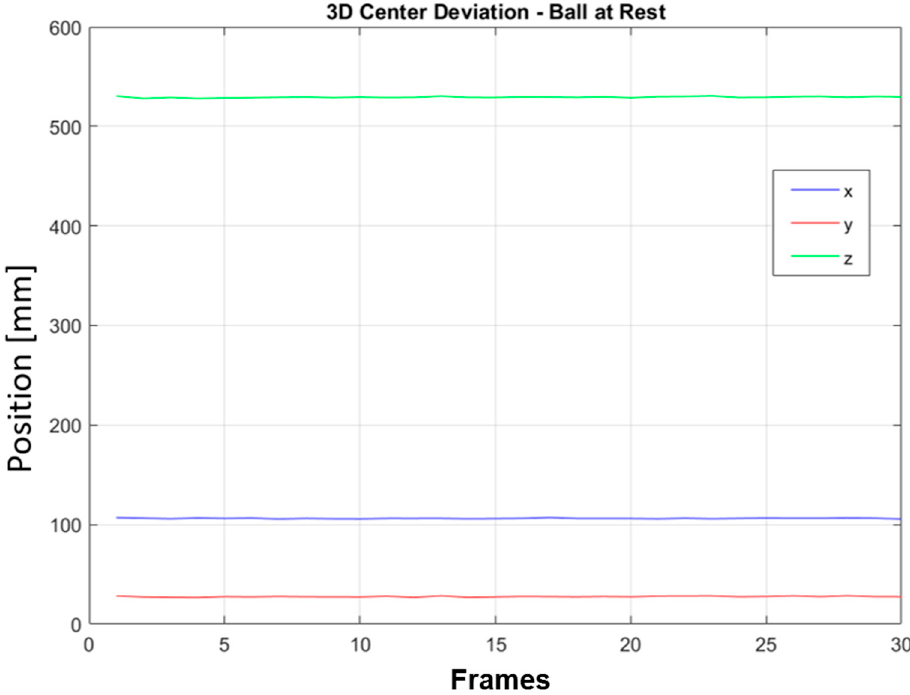
Figure 12. Ball center coordinates calculated using color segmentation algorithm and sphere fitting procedure over thirty consecutive acquisitions for the ball at rest.